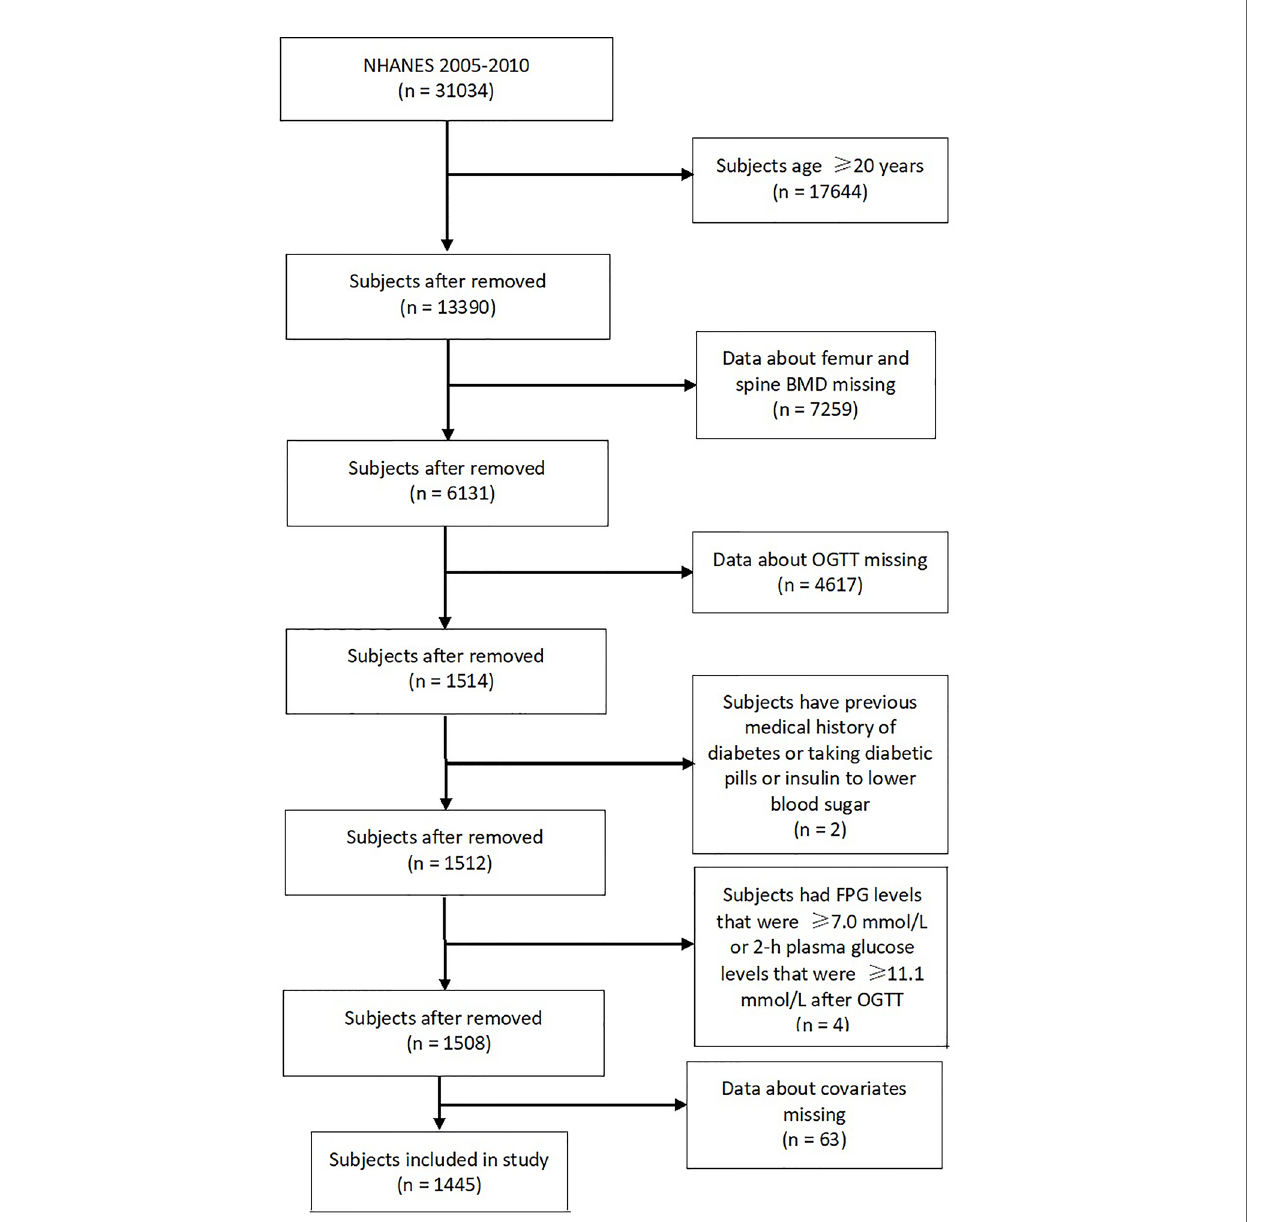
FIGURE 1 | Flowchart of the selection of